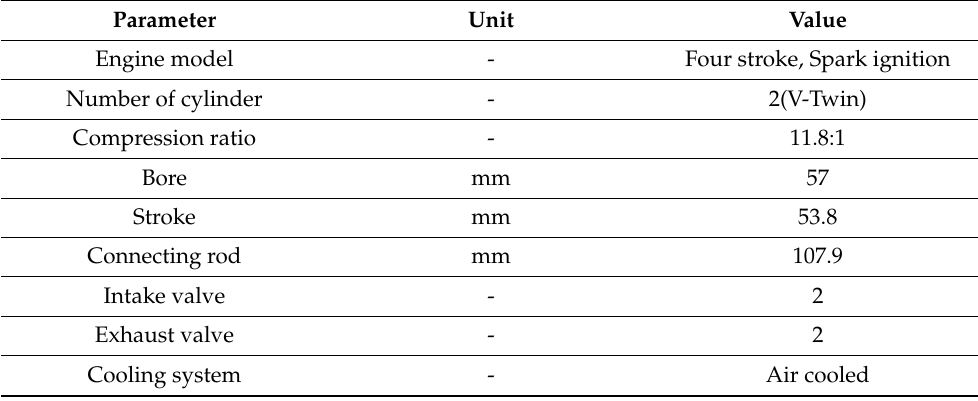
Table 1. Engine Table 1. Engine specifications.